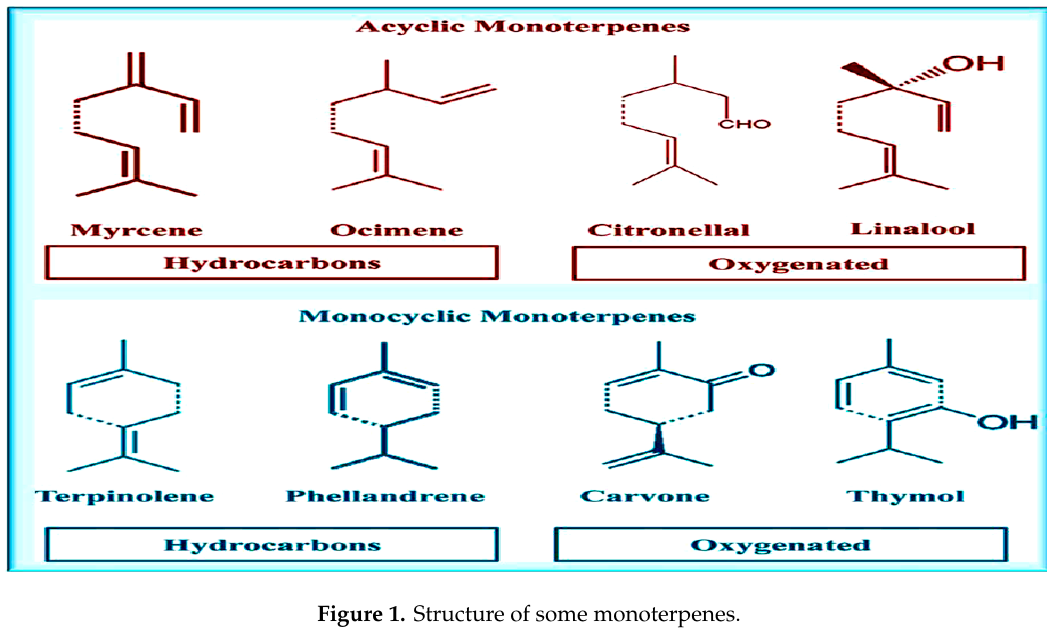
Figure 1. Structure of some monoterpenes.